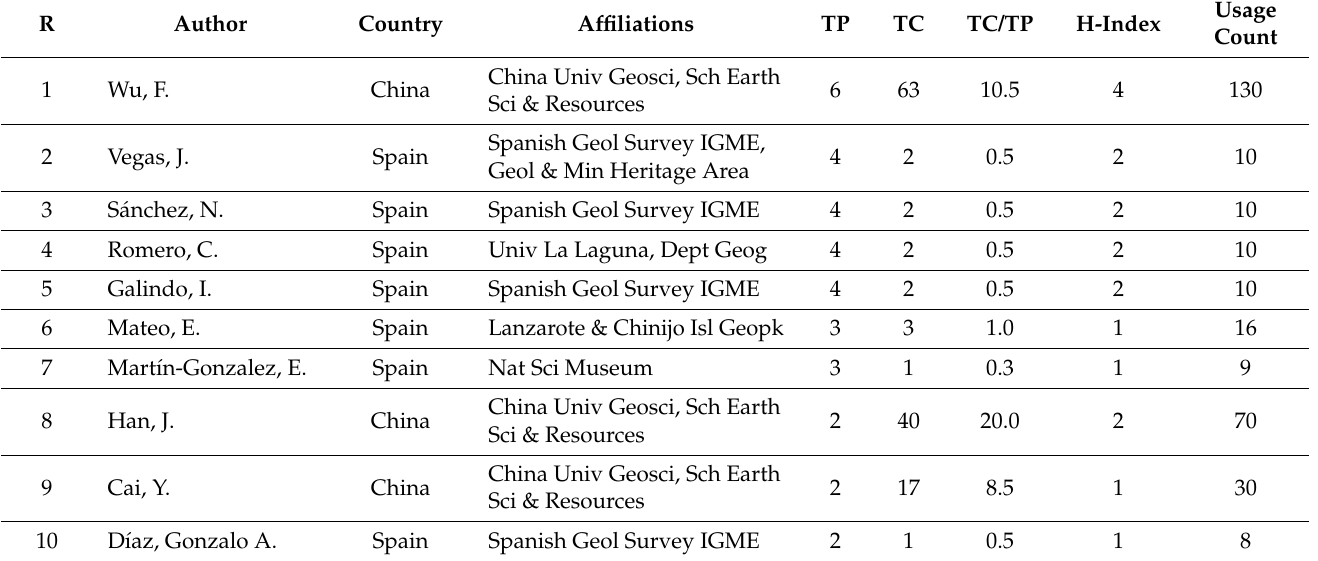
Table 3. Top 10 authors by the number of